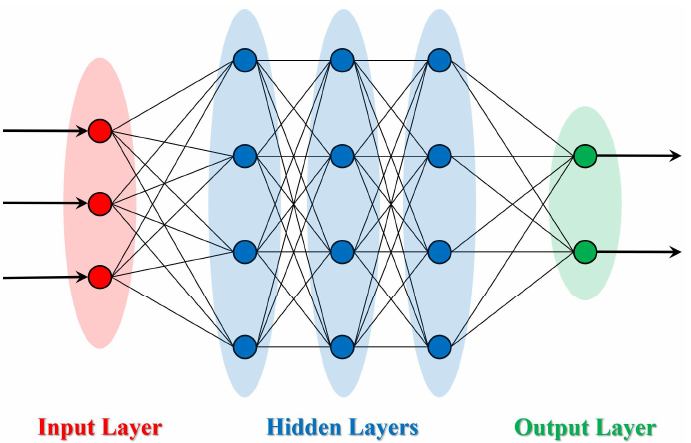
Figure 1. The basic structure of a feedforward (deep) neural network. A feedforward (deep) neural network consists of three main parts: an input layer (red units), an output layer (green units), and a number of hidden layers (blue units). The input data is sent into the network from the input layer, and then the hidden layer processes the data, which yields an output.